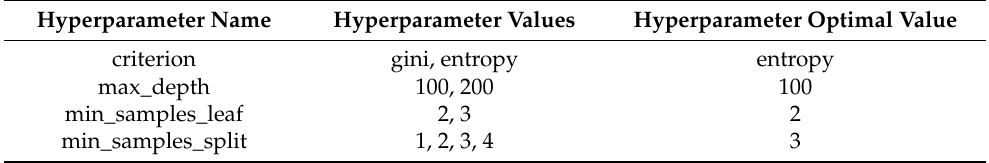
Table 4. Decision Tree best hyperparameter combination after hyper-tuning.